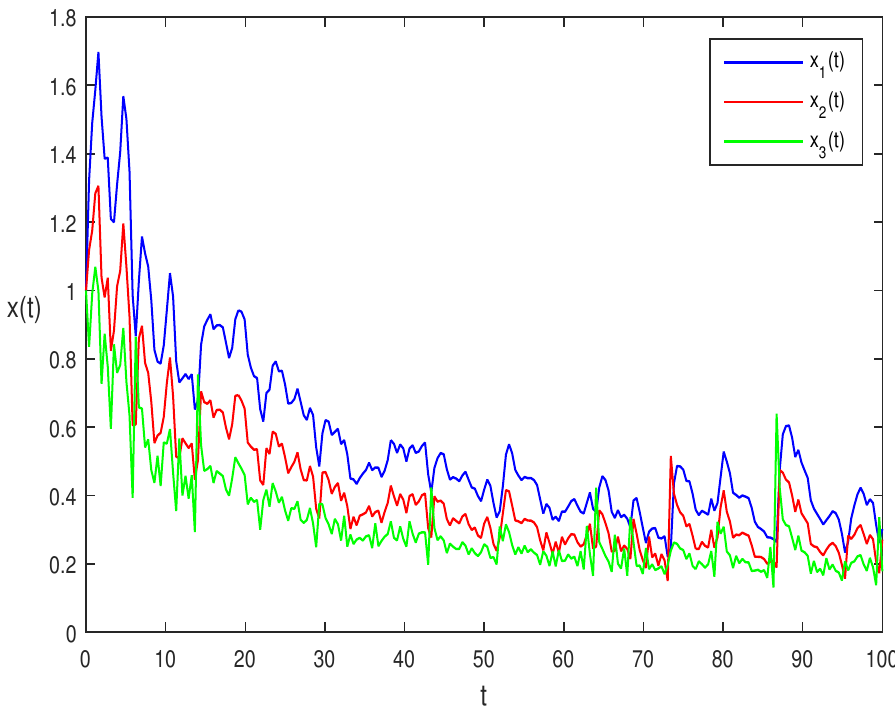
Figure 1. Solution for each class of stochastic delay NGM systems from Equation (1).